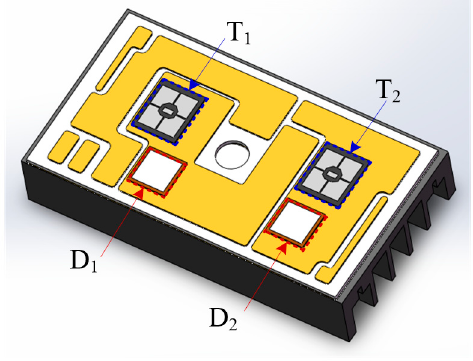
Figure 7. 3D simulation module of inspected IGBT with heat-sink.